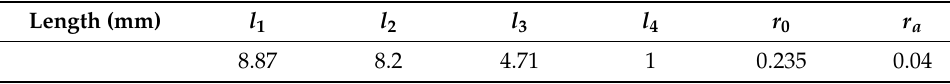
Table 3. Structure parameters of